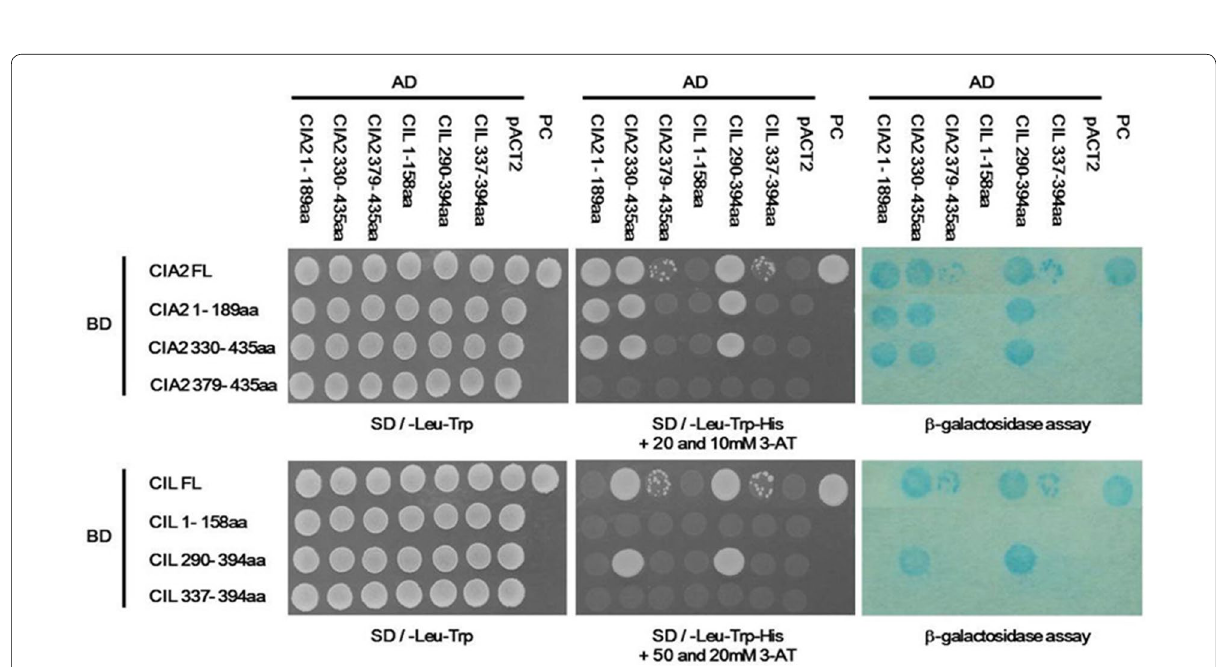
Fig. 3 Domain swap analysis of CIA2 and CIL fragments, as determined by Y2H assay. The pAS2‑1 and pACT2 vectors harbor GAL4 BD and GAL4 AD, respectively. The CIA2 and CIL fragments were ligated into pAS2‑1 or pACT2 vectors. Colonies were assayed for SD/‑Leu‑Trp autotrophy, SD/‑Leu‑Trp‑Trp 20 or 50 mM 3‑AT autotrophy, and β‑galactosidase activity. pACT2, negative control. PC, positive control containing pVA3‑1 and +